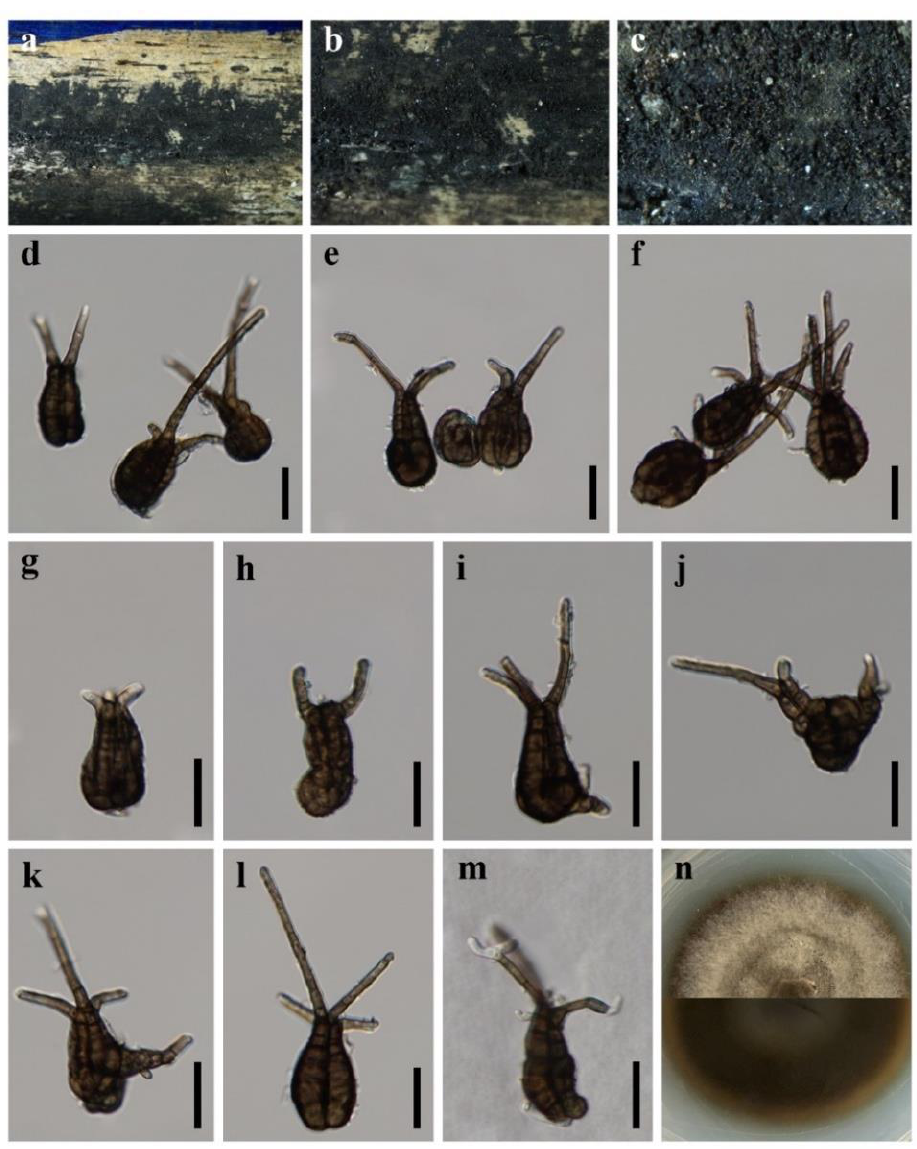
Figure 6. Pseudotetraploa bambusicola (HKAS 123095, holotype ) ( a – c ) Colonies on natural substratum. ( d – l ) Conidia. ( m ) Germinating conidium. ( n ) Colony on PDA from above and below. Scale bars: ( d – m ) = 20 μm.